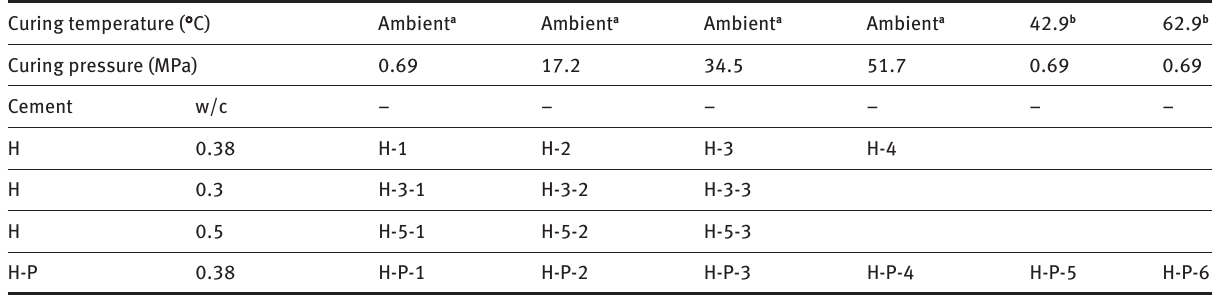
Table 3: Test series II (duration of curing = 72 h). Curing temperature ( ° C)